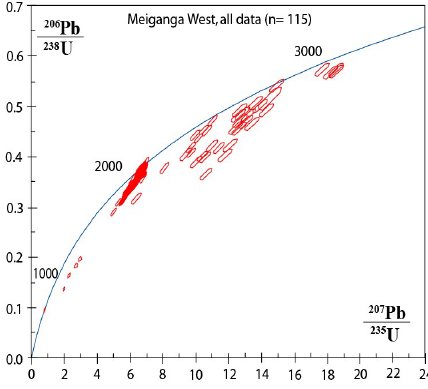
Figure 5. U–Pb discordia diagram for the western Meiganga detrital zircons.